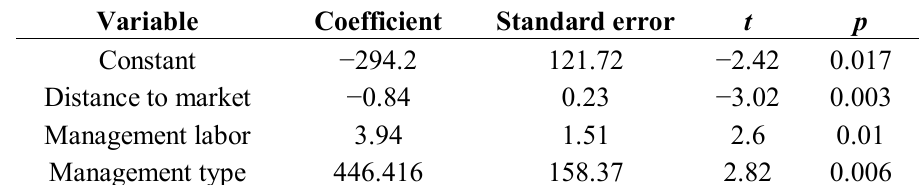
Table 3. Factors significantly affecting bamboo commercialization in three Ethiopian sites ( R ² = 0.39, p <